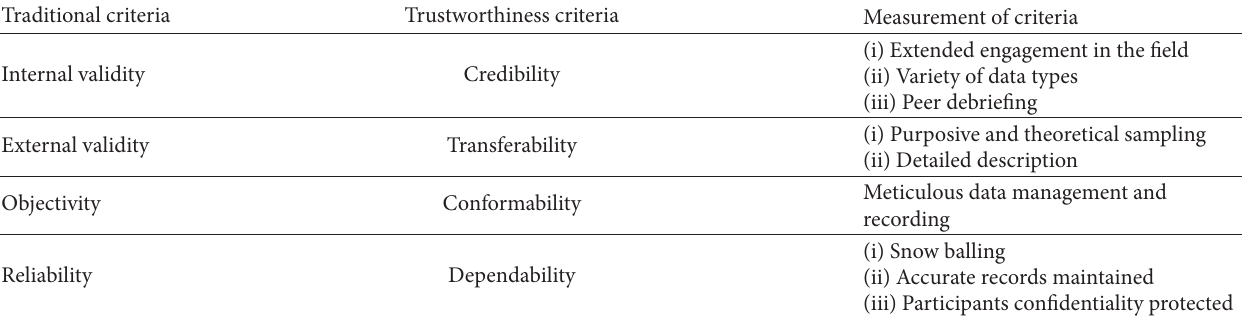
Table 1: Comparison of traditional and constructivist